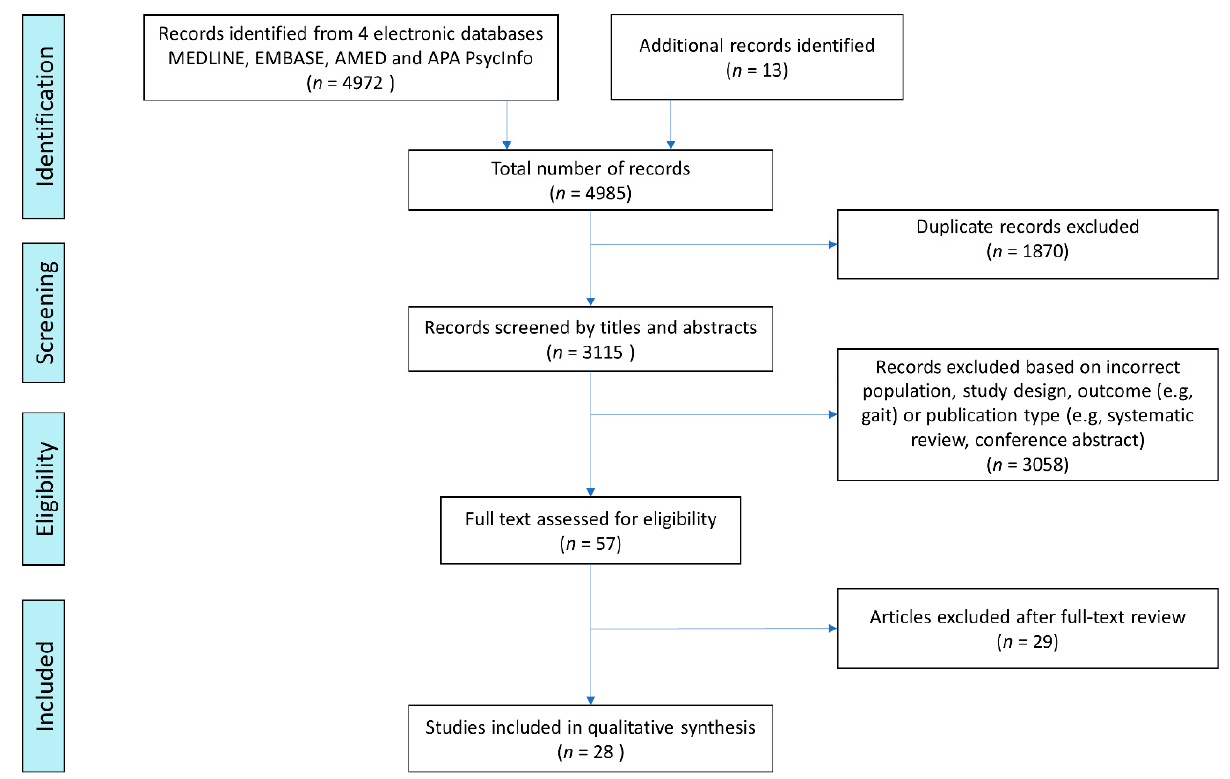
Figure 1. PRISMA flowchart summarising the search process.